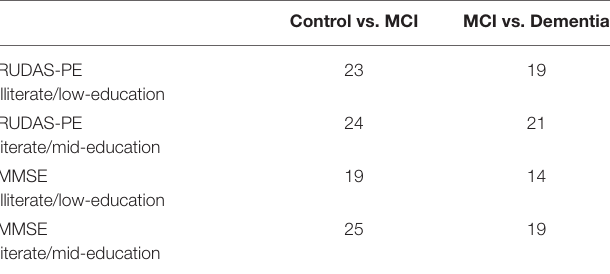
TABLE 4 | Comparison of the RUDAS-PE cut-off scores for screening dementia in illiterate and literate populations. Control vs.